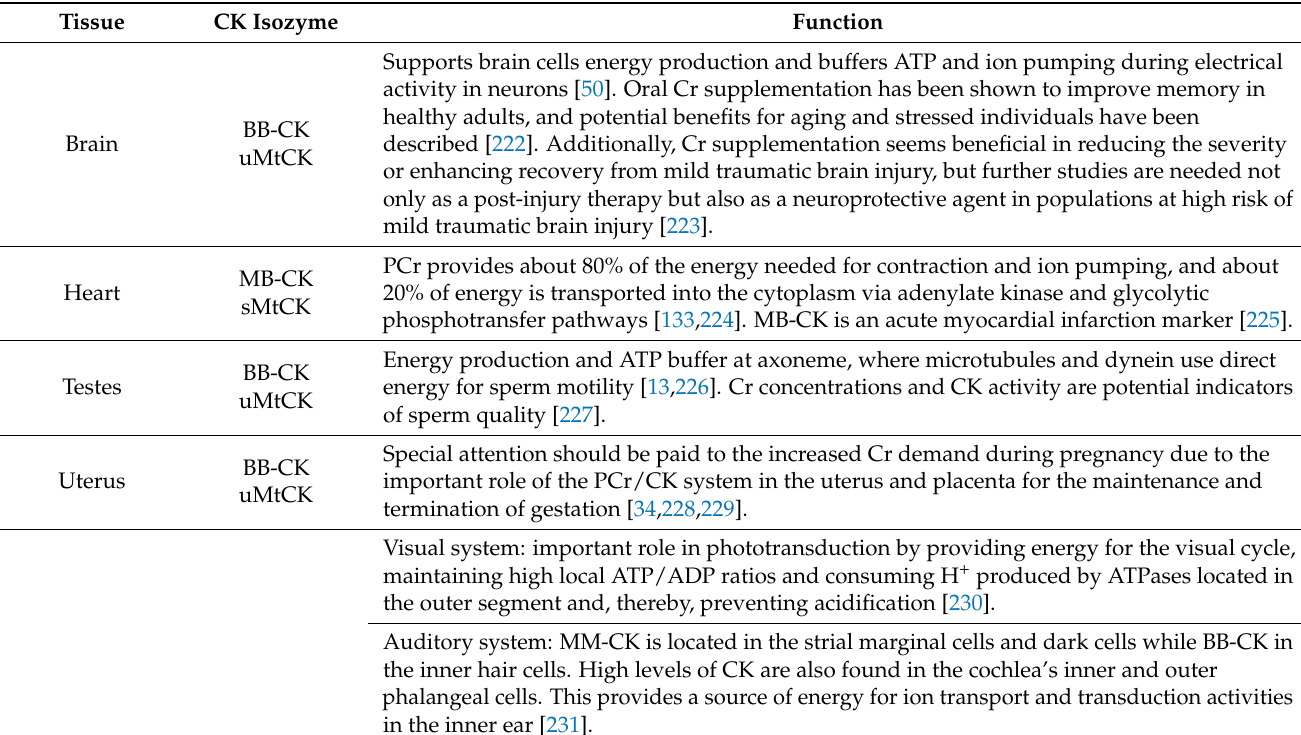
Table 2. Creatine kinases and creatine among